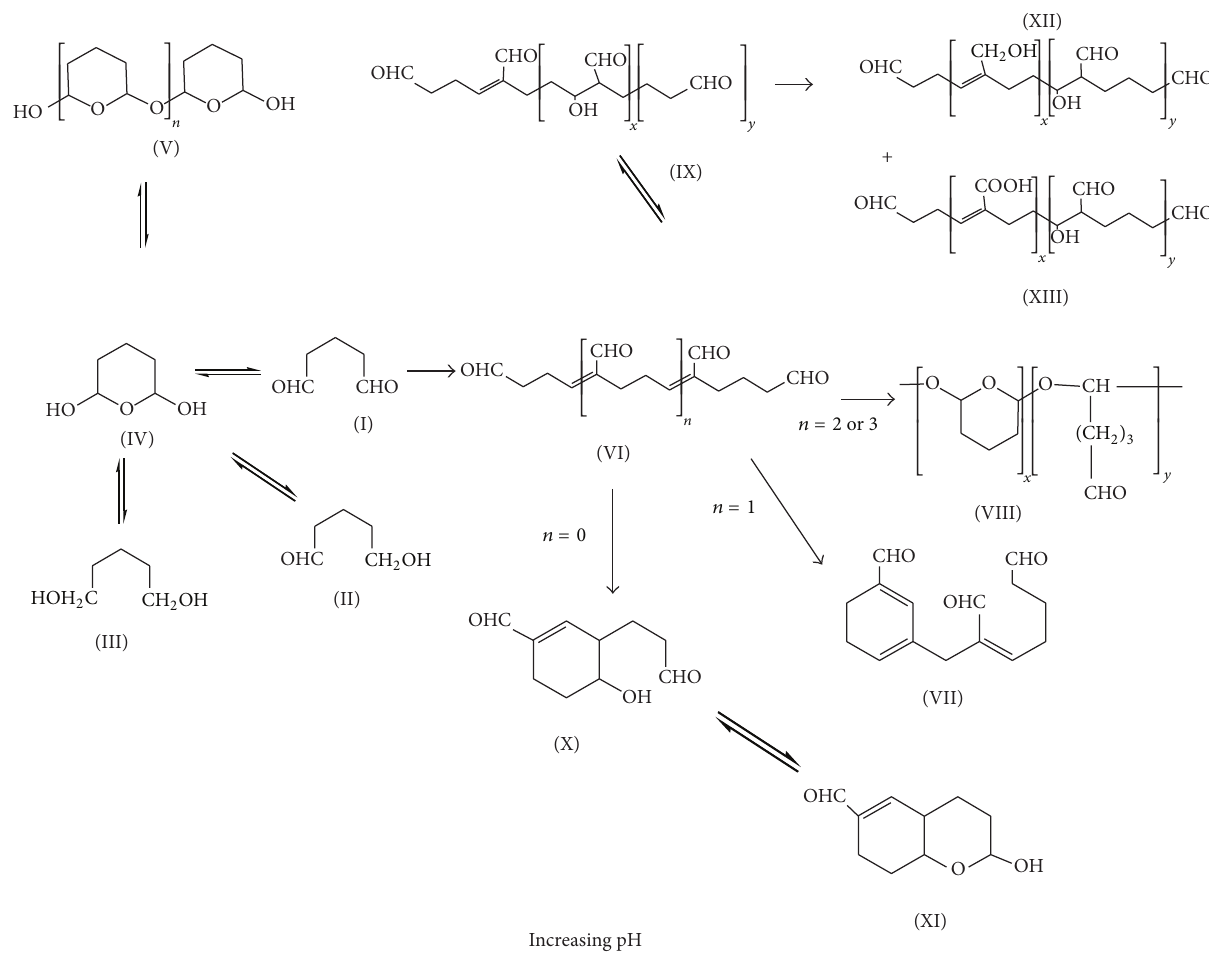
Figure 1: Possible molecular structures of intra-intermolecular polymerization of glutaraldehyde in aqueous solutions. Structure (I): normal glutaraldehyde monomer